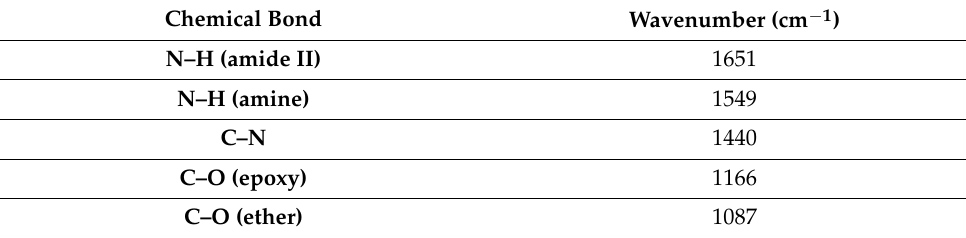
Figure 1. FT-IR spectra of rGO-NH 2 before and after functionalization with CE. Table 1. FT-IR peaks spectral assignments.